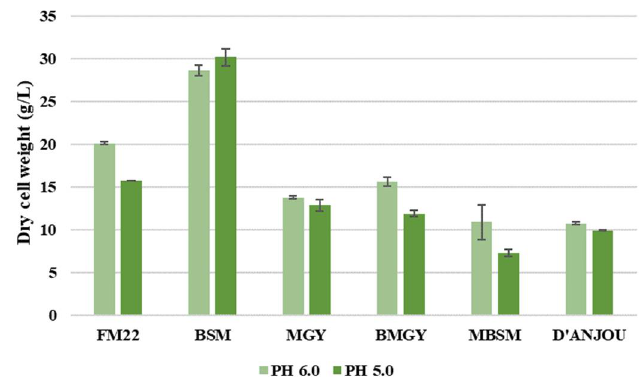
Figure 2. Dry cell weight comparison of P. pastoris at pH 6.0 and 5.0 when grown in different media formulations at 30 °C.